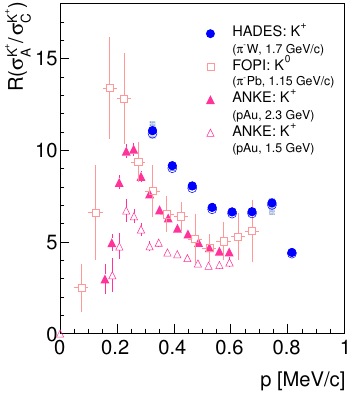
Figure 2. Ratio of inclusive K + ( K 0 ) cross-sections produced by pions / protons on heavy and light targets as a function of the kaon momentum. The full (open) circle resembles the ratio of K + in this experiment. The open squares depict the ratio of K 0 produced on Pb and C s targets measured by FOPI at an beam momentum of 1.15 GeV / c [3]. While, the full (open) triangle show the ratio of K + produced on Au and C targets of proton-induced reactions at 2.3 (1.5) GeV (ANKE)